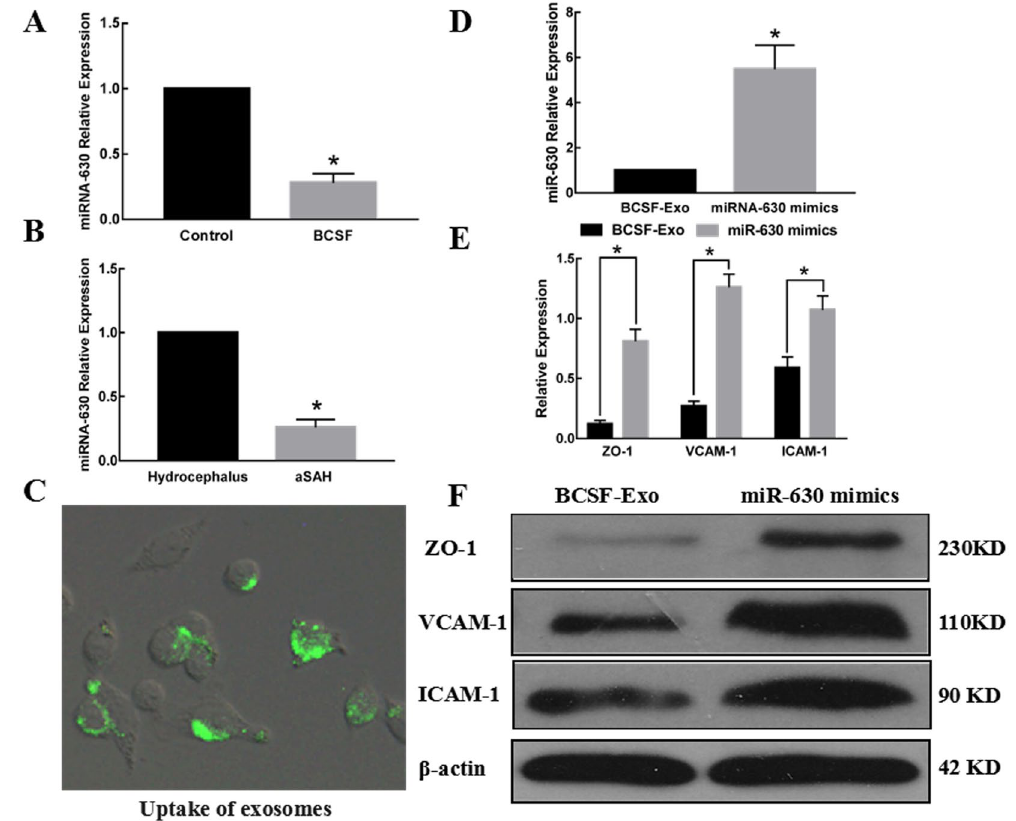
Figure 4. The influence of exosomal miR-630 on BMECs. ( A ) The expression of exosomal miR-630 was significantly lower in the BCSF treated group ( p < 0.05). ( B ) The expression of exosomal miR-630 was also significantly reduced in SAH patients ( p < 0.05). ( C ) The uptake of the fluorescently labelled miR-630 mimics transfected exosomes was evident in 90% BMECs after 12 h of incubation. ( D ) miR-630 was significantly increased after miRNA-630 mimics transfection ( p < 0.05). ( E , F ) The expression of ICAM-1, VCAM-1 and ZO-1 in BMECs cocultured with exosomes transfected by miR-630 mimics was significantly increased compared to the control group ( p <